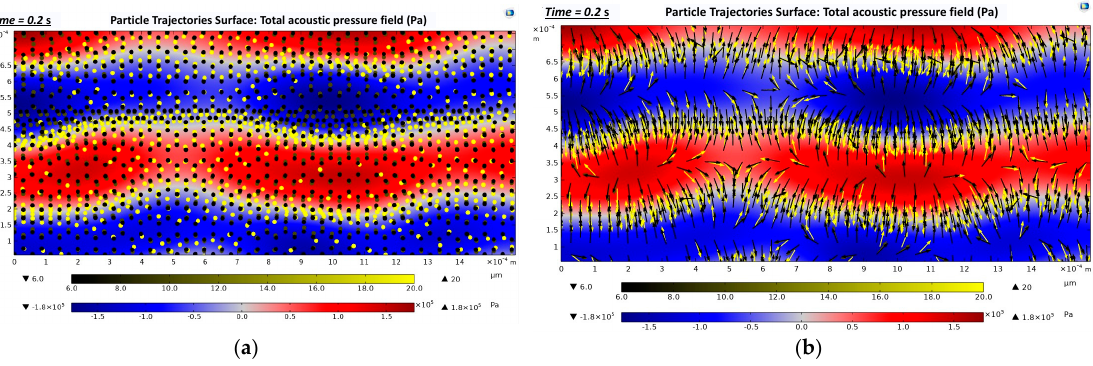
Figure 8. Trajectories of the cells during 0.2 s of exposure to a 3.3 MHz driving frequency (zoom-in images that show three pressure nodal lines occurring in the straight rectangular section): ( a ) Location of the cells in t = 0.2 s along the straight rectangular section of the microchannel; ( b ) Motions of the cells while they move towards the pressure nodal lines in t = 0.2 s.